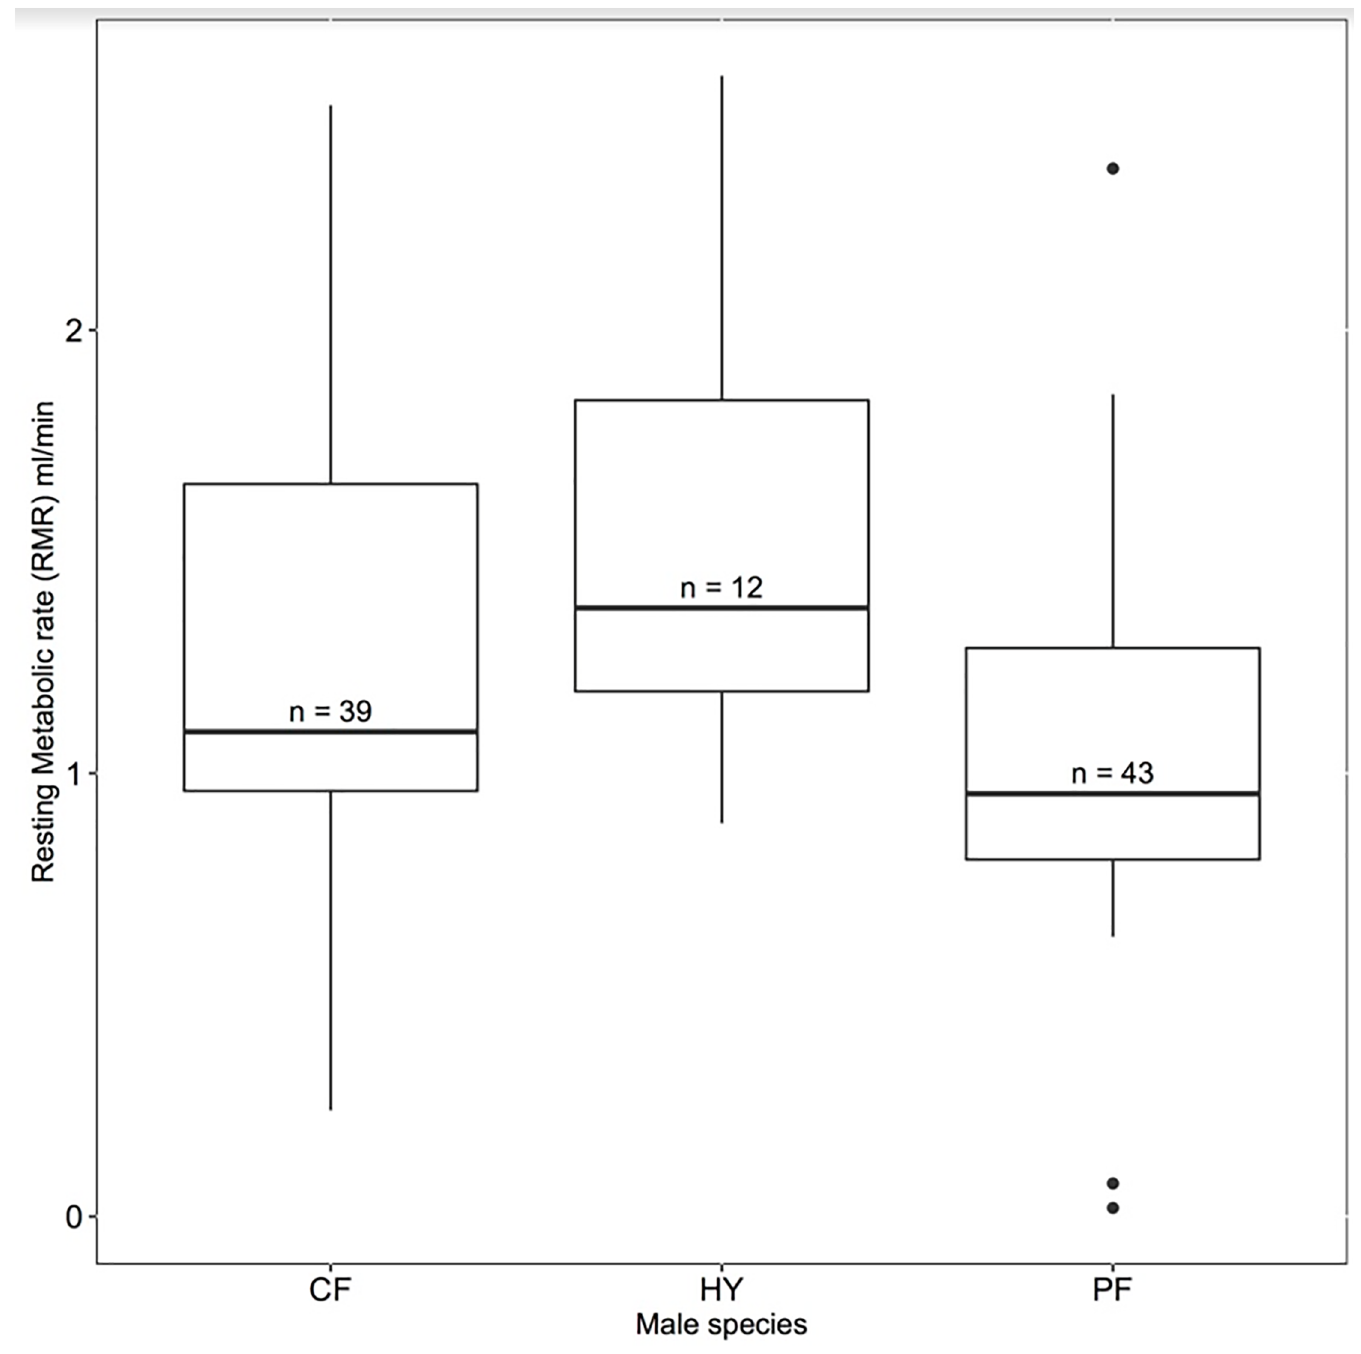
Fig 1. A comparison of whole organism resting metabolic rate (ml/minute) among collared (CF, n = 39), pied (PF, n = 43) and hybrid (HY, n = 12) male flycatchers breeding in 2013, 2014, and 2015 on O¨ land. We found that hybridmales tendedto have highermetabolicthan either parentalspecies.